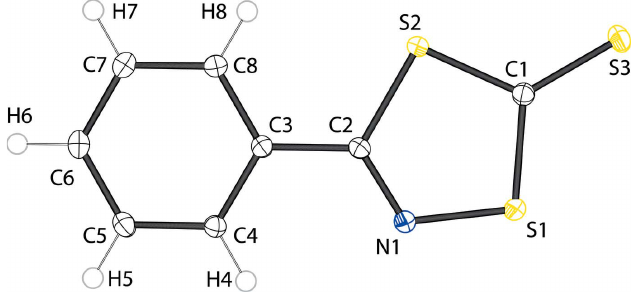
Figure 1 The molecular structure of the title compound, showing anisotropic displacement ellipsoids projected at 50% probability.